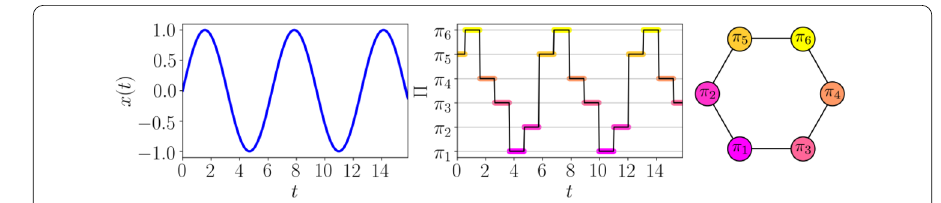
Figure 9 Example formation of an ordinal partition network for a sinusoidal signal x ( t ) = sin( t ) with permutations of dimension n = 3. The resulting permutation sequence (cid:8) shows how these permutations transition, which is captured by the ordinal partition network on the